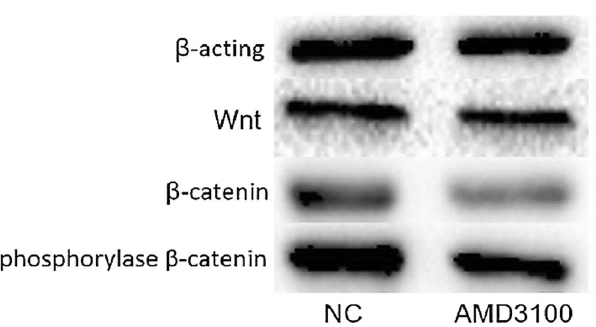
Figure 9. The protein expression of Wnt, β -catenin and the phosphorylase of β -catenin in RASNF-01001 cells after treated with AMD3100. The expression levels of β -catenin and the phosphorylase of β -catenin were decreased in AMD3100 group, but the expression Wnt was not significantly changed after treated with